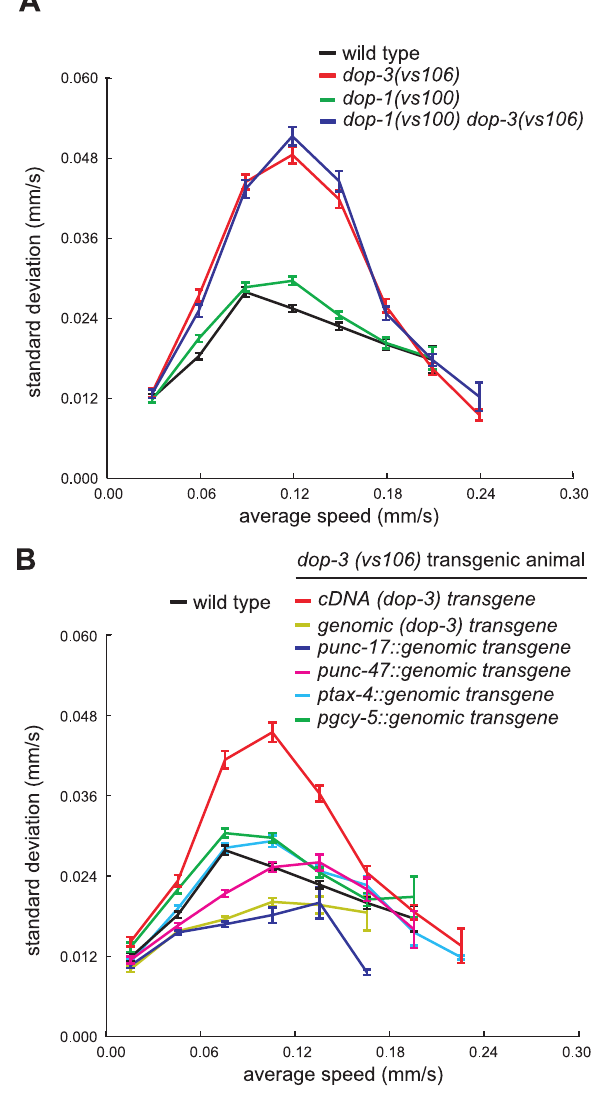
Figure 7. While mutations in dop-1 fail to suppress dop-3 speed fluctuations, dop-3 genomic constructs do, regardless of the promoter used. The average standard deviations of speed measure- ments within individual tracks for (A) wild-type animals, mutant animals, and (B) transgenic strains on a bacterial lawn. p-values for differences between standard deviation curves for each genotype were calculated using two-way ANOVA. Tracks were first grouped by average speed. Error bars, SEMs. (A: wild-type n=934 tracks; dop-3(vs106) n=941; dop- 1(vs100) n=1045; dop-1(vs100) dop-3(vs106) n=887. B: wild-type n = 934 tracks, dop-3 cDNA transgenic n= 853, dop-3 genomic transgenic n=861, P unc-17::dop-3 genomic transgenic n=791, P unc-47dop-3 genomic transgenic n=911, P tax-4::dop-3 genomic transgenic n=1005, P gcy-5::dop-3 genomic transgenic n=917. all tracks . 30 sec).